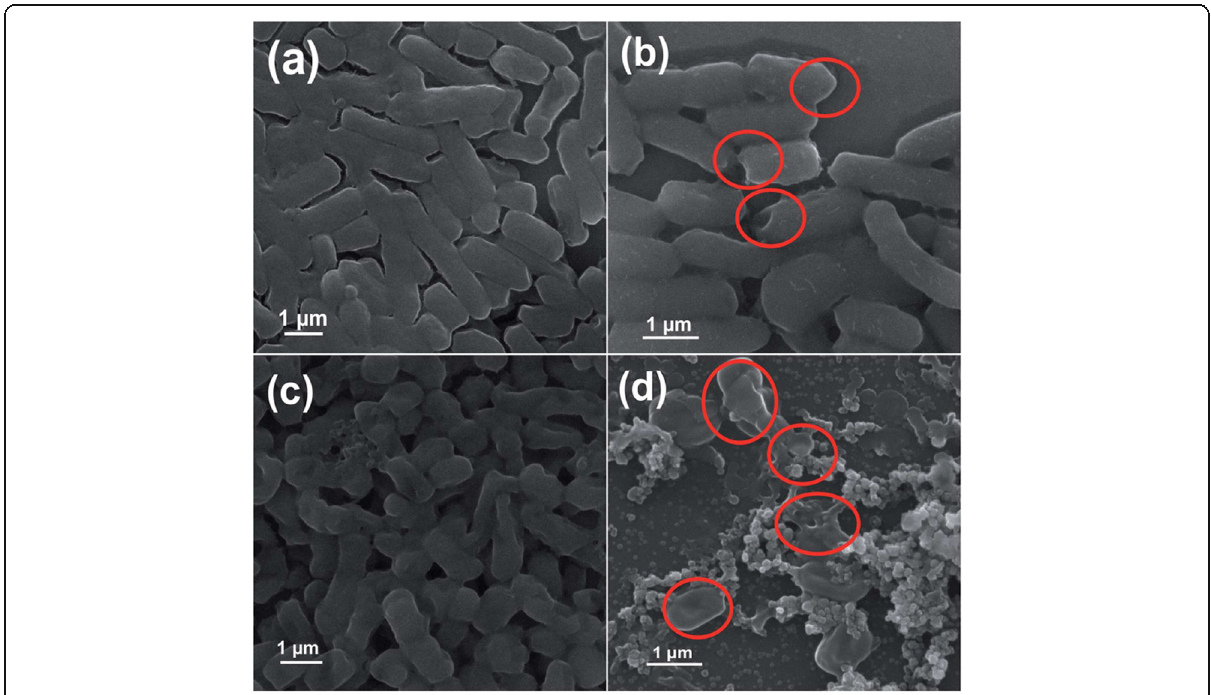
Fig. 10 SEM images of bacterial cells. Samples of E. coli ( a ) untreated and ( b ) treated with 5NZO. Samples of A. baumannii ( c ) untreated and ( d ) treated with 5NZO. Red circles indicate areas of cell membrane disruption. Reproduced from ref. [21] with permission from The Royal Society of